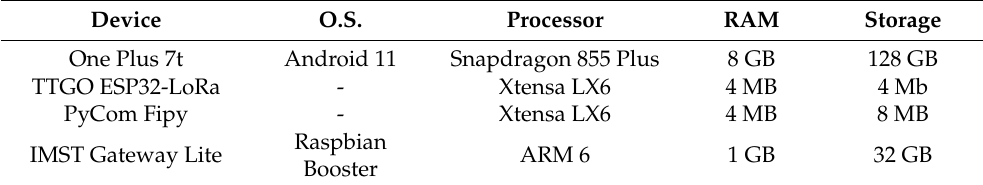
Table 2. Main characteristics of hardware resources.